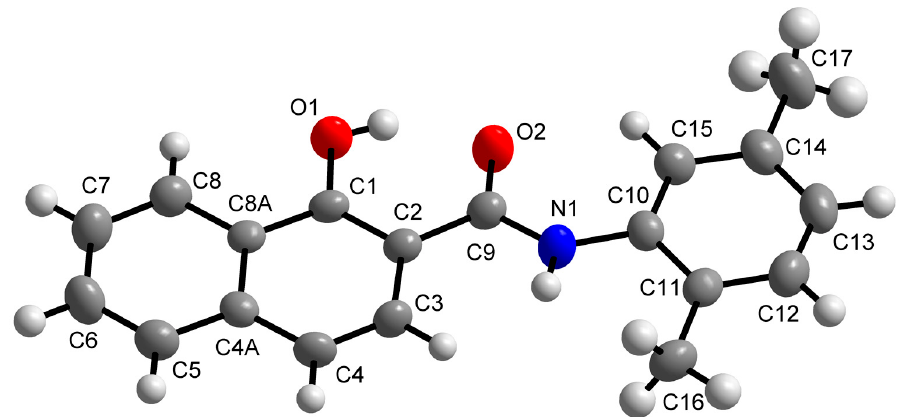
Figure 1. Molecular structure of N -(2,5-dimethylphenyl)-1-hydroxynaphthalene-2-carboxamide ( 11 ). Non-H atoms are drawn as thermal ellipsoids at 50% probability level. H-atoms are not labelled and are displayed as balls in light-grey colour. Table 2. Crystal data and structure refinement for 11 .